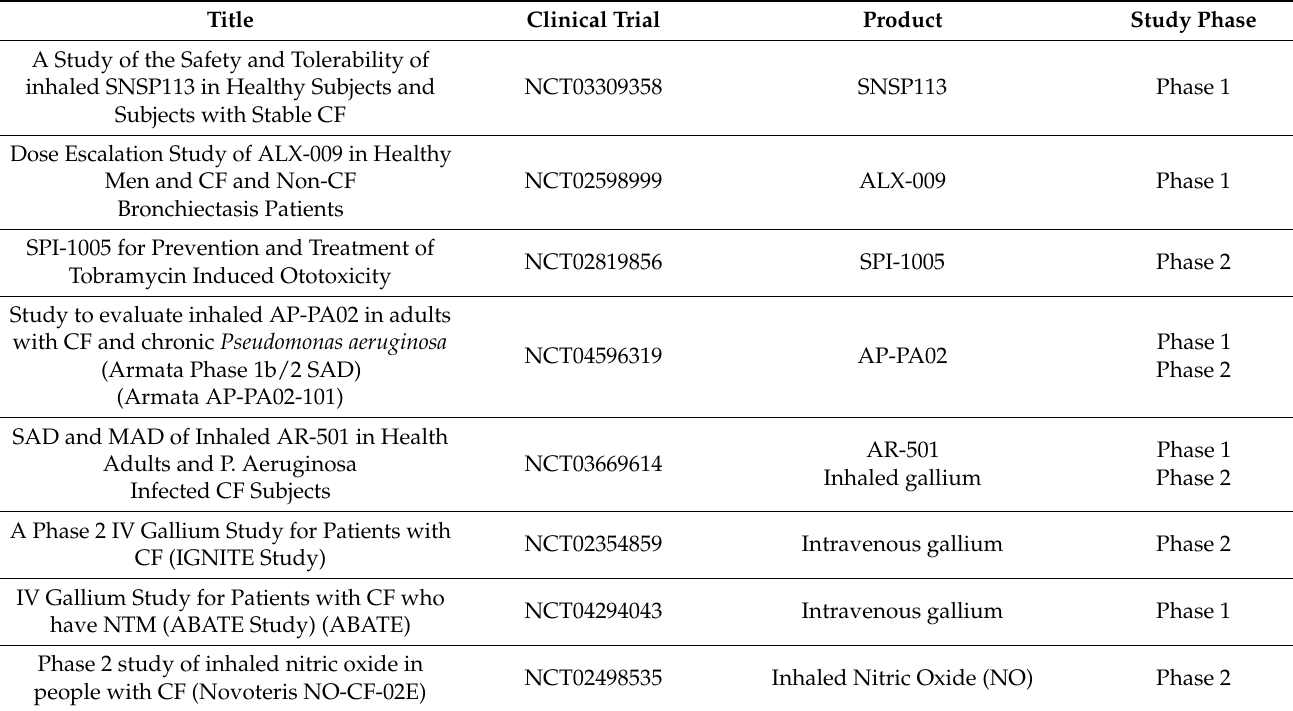
Table 4. New anti-infective therapy research